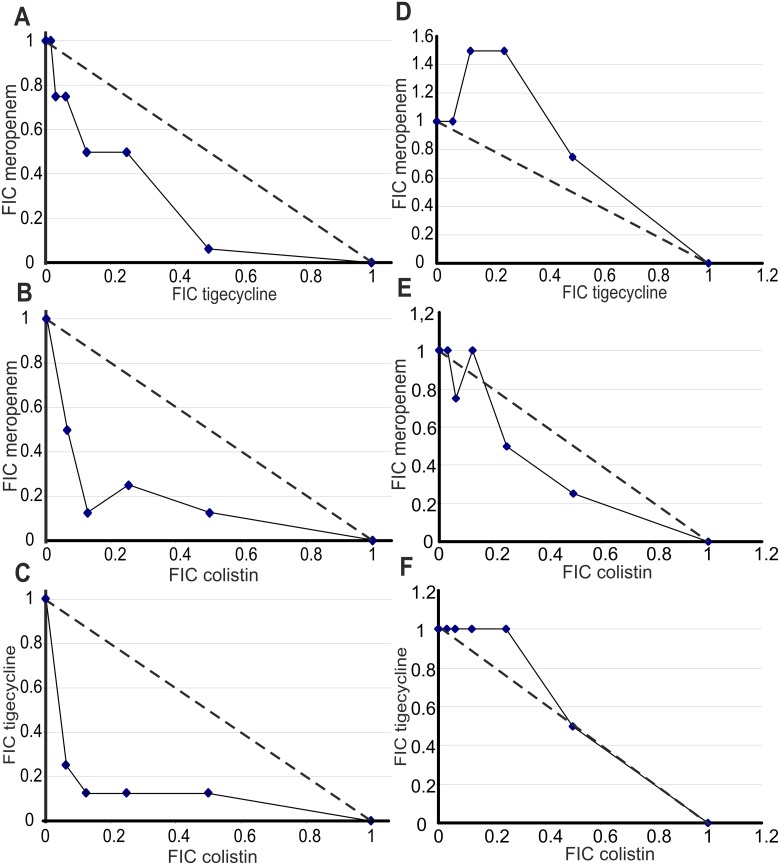
Exemplary isoboles of the double combinations of the antibiotics.A-C: Isoboles of strain NRZ 00246 (OXA-48 producer) exhibiting synergistic effects. D-F: Isoboles of strain RKI 318/11 (KPC producer) yielding no synergism. FIC = fractional inhibitory concentration.